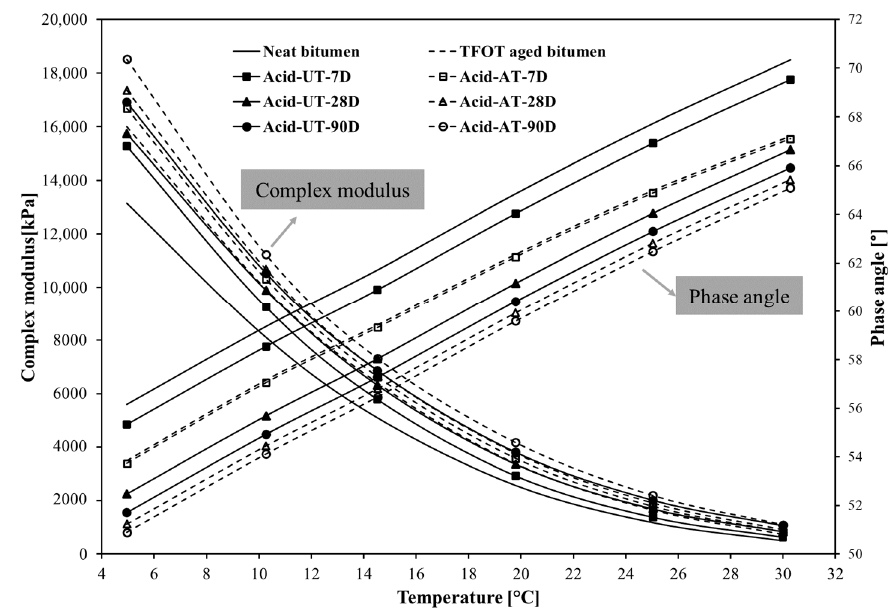
Figure 5. The complex modulus and phase angle of the bitumen under acid rain erosion at low temperature (5–30 °C).